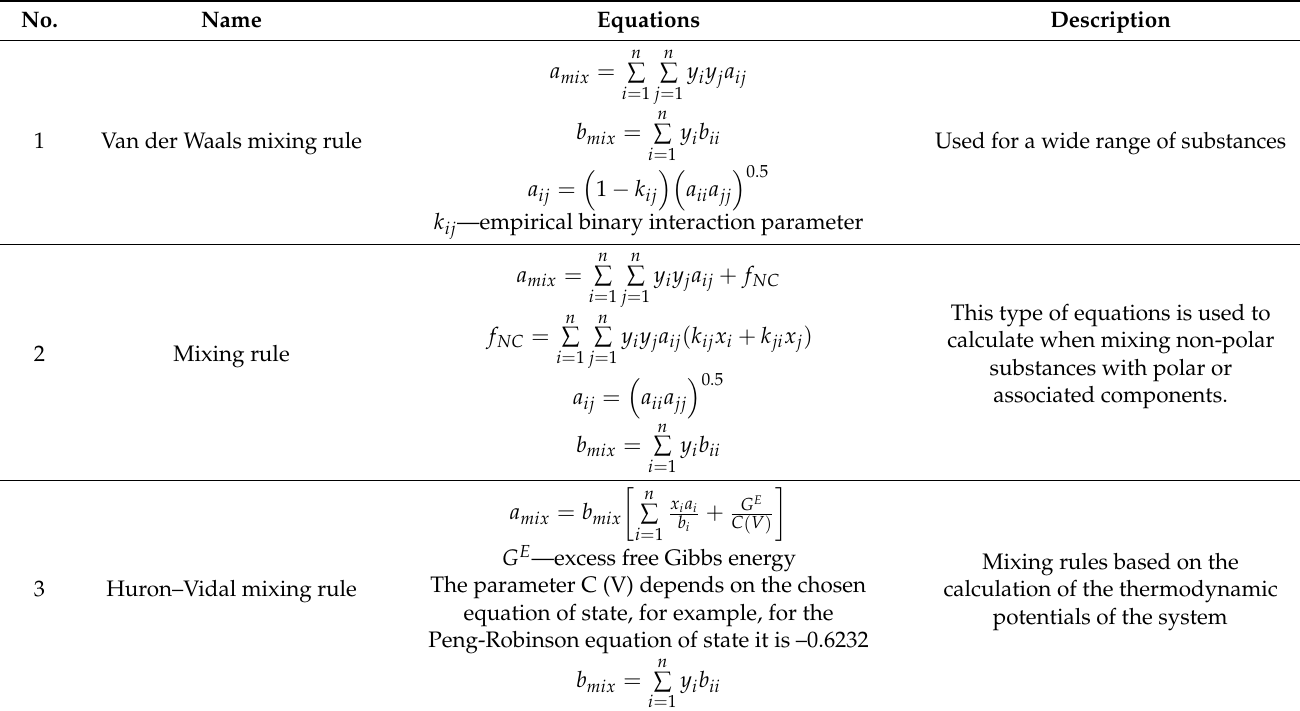
Table 2. List of mixing rules